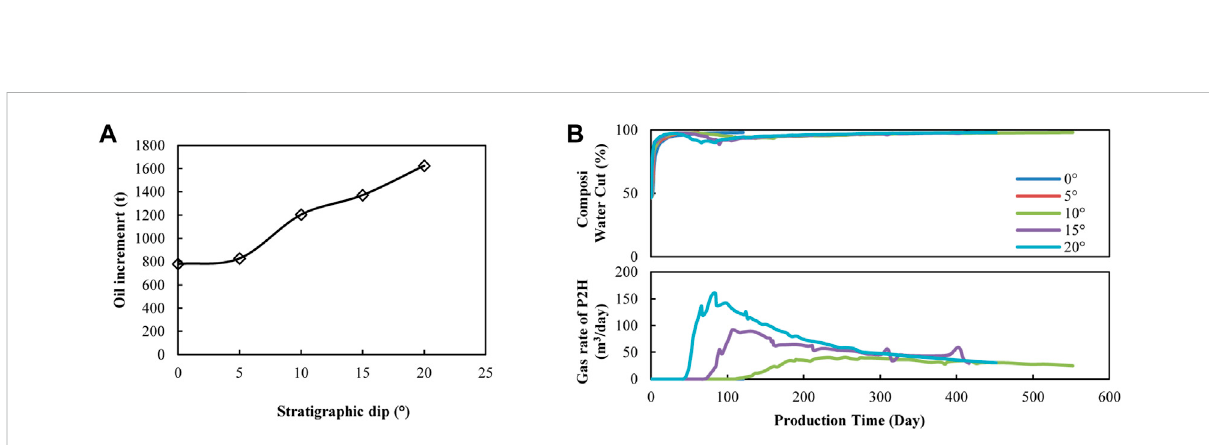
FIGURE 12 Production performance of different stratigraphic dips for well-to-well interplay of CO 2 huff-n-puff. (A) Oil increase vs. interwell spacing. (B) Composite water cut and production gas rate vs . time.